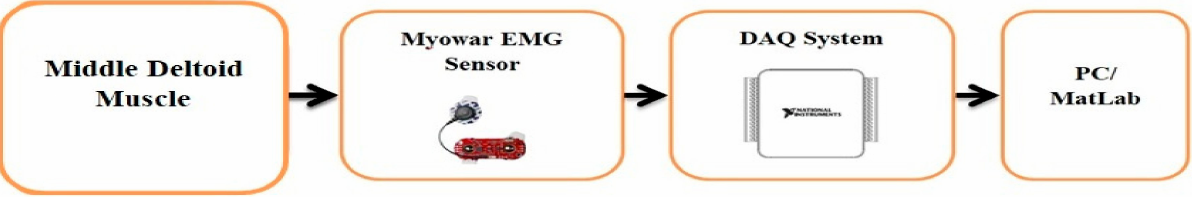
Figure 2. Experiment Setup and